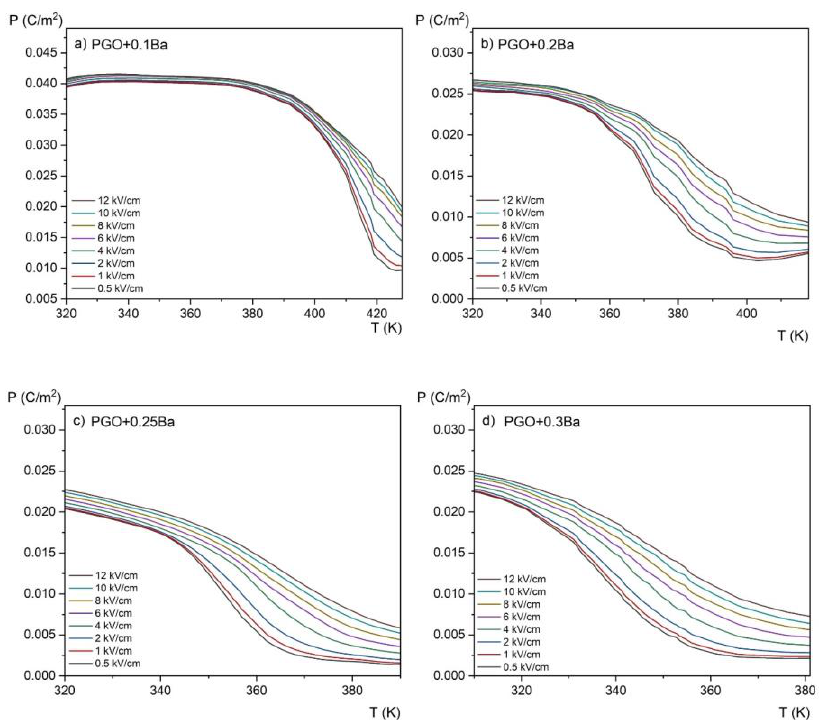
Figure 9. Temperature dependence of the spontaneous polarization measured at different electric fields in the range of 0.5–12 kV/cm for PGO + xBa crystals: ( a ) PGO + 0.1Ba, ( b ) PGO + 0.2Ba, ( c ) PGO + 0.25Ba, ( d ) PGO + 0.3Ba.